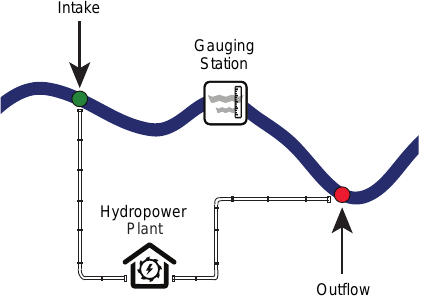
Figure 1. Example of gauging station bypassed by a water